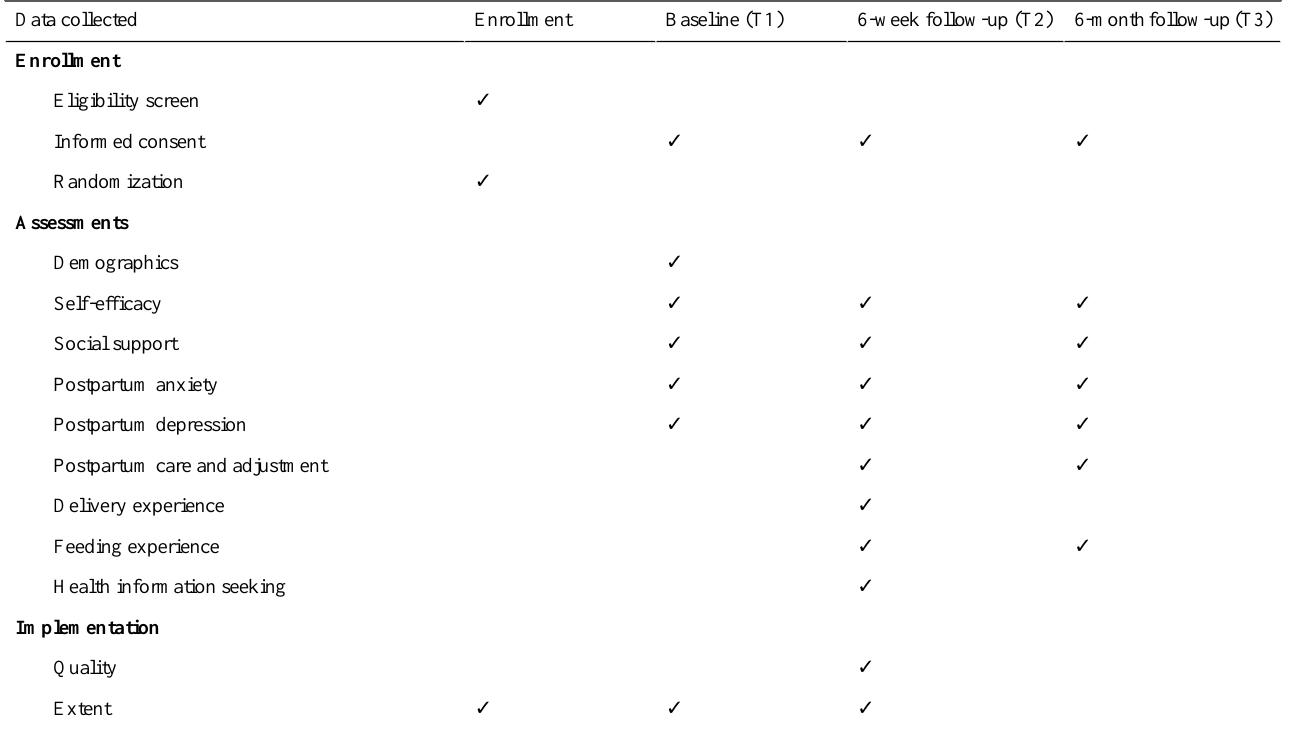
Table 1. Data collected at the study outcome assessment time